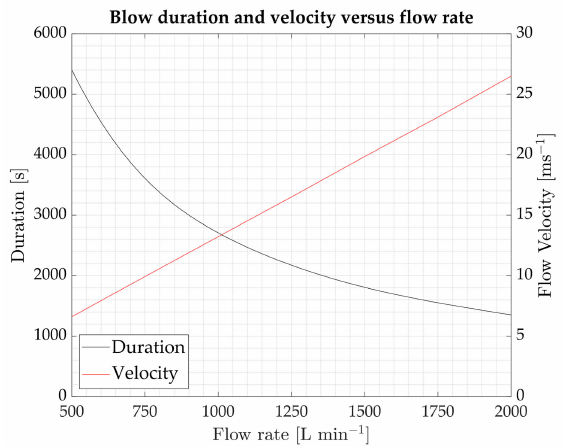
Figure 6. The variation of blowing duration and flow velocity as a function of the set flow rate for a fixed volume and pressure of compressed air. A low flow rate corresponds to long duration, slow velocity blowing, and high flow rate corresponds to short duration, high velocity